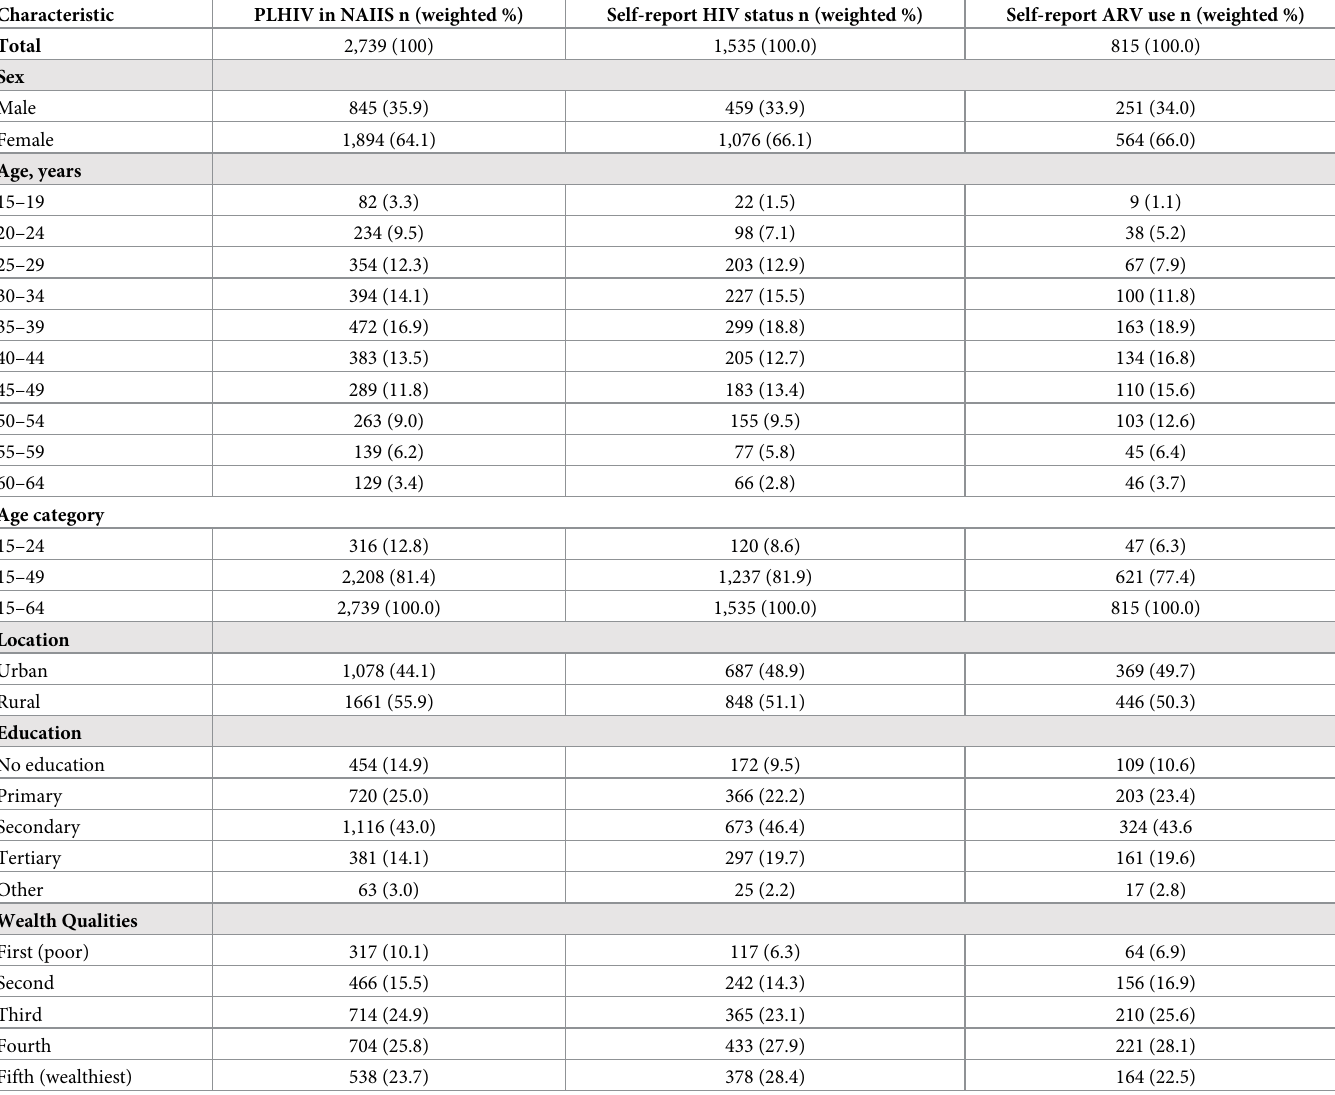
Table 2. Sociodemographic characteristics of individuals who self-reported HIV status and antiretroviral drug (ARV) and who tested HIV positive during the Nige- ria HIV/AIDS and Indicator Survey (NAIIS 2018). Characteristic PLHIV in NAIIS n (weighted %) Self-report HIV status n (weighted %) Self-report ARV use n (weighted